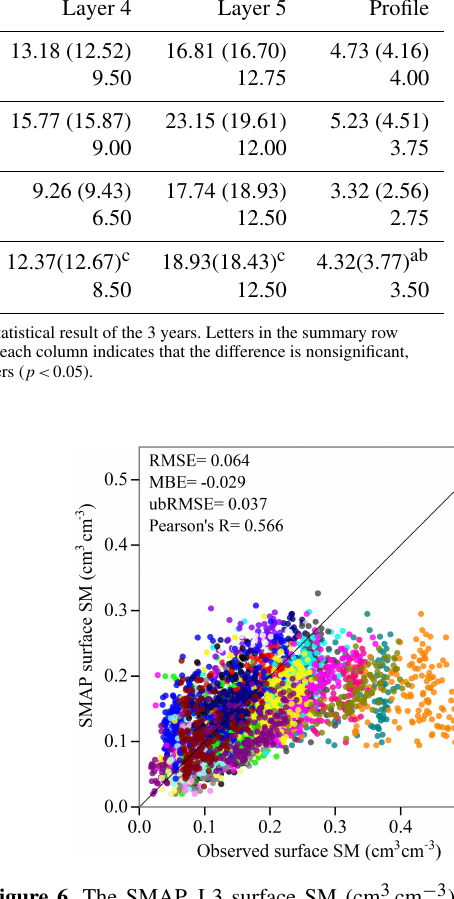
Figure 6. The SMAP_L3 surface SM (cm 3 cm − 3 ) versus in situ observations at the surface (5cm) for the 35 soil moisture stations. Color indicates station. The averaged metrics (RMSE, MBE, R , ubRMSE) are for all 35 stations during the growing seasons of 2015 and